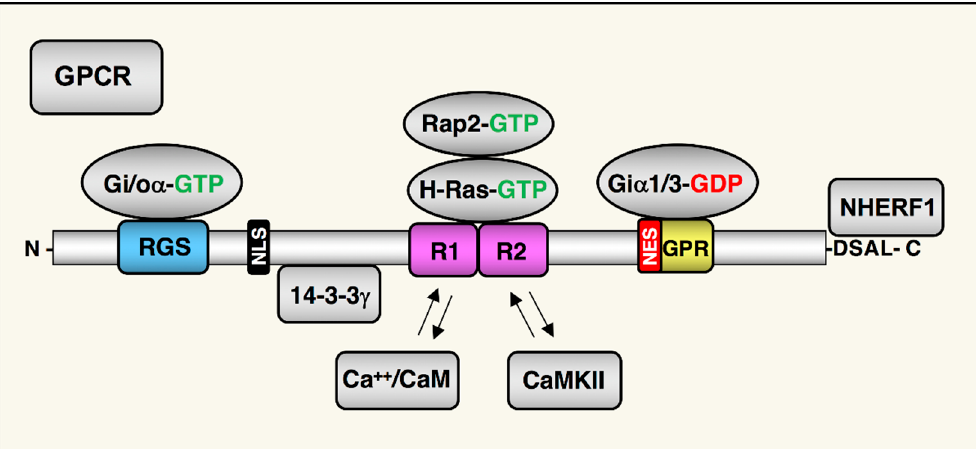
Figure 1. RGS14 structural organization and interacting partners. Regulator of G-protein signaling 14 (RGS14) is a ~62 kDa protein that contains three conserved domains and two motifs. The RGS domain serves as a GTPase activating protein (GAP) for active, GTP-bound G α i/o proteins; the tandem Ras binding domains (R1/R2) enable interaction with H-Ras and Rap2; and the GoLoco/G protein regulatory motif (GPR) promotes binding to inactive, GDP-bound G α i1/3 proteins and inhibits dissociation of GDP from G α i1/3. RGS14 also contains a nuclear localization sequence (NLS) in the linker region between the RGS and R1/R2 domains and a nuclear export sequence (NES) embedded within the GPR motif. RGS14 interacts with 14-3-3 at phospho-Ser218 in the linker region between the RGS and R1/R2 domains, and also with calcium/calmodulin (Ca 2+ /CaM) and Ca 2+ /CaM kinase II (CaMKII) at undefined sites within the R1/R2 domain. Lastly, a PDZ-recognition motif (DSAL) is found at the C-terminus of human/primate (but not rodent) RGS14, which mediates RGS14 interactions with NHERF1.